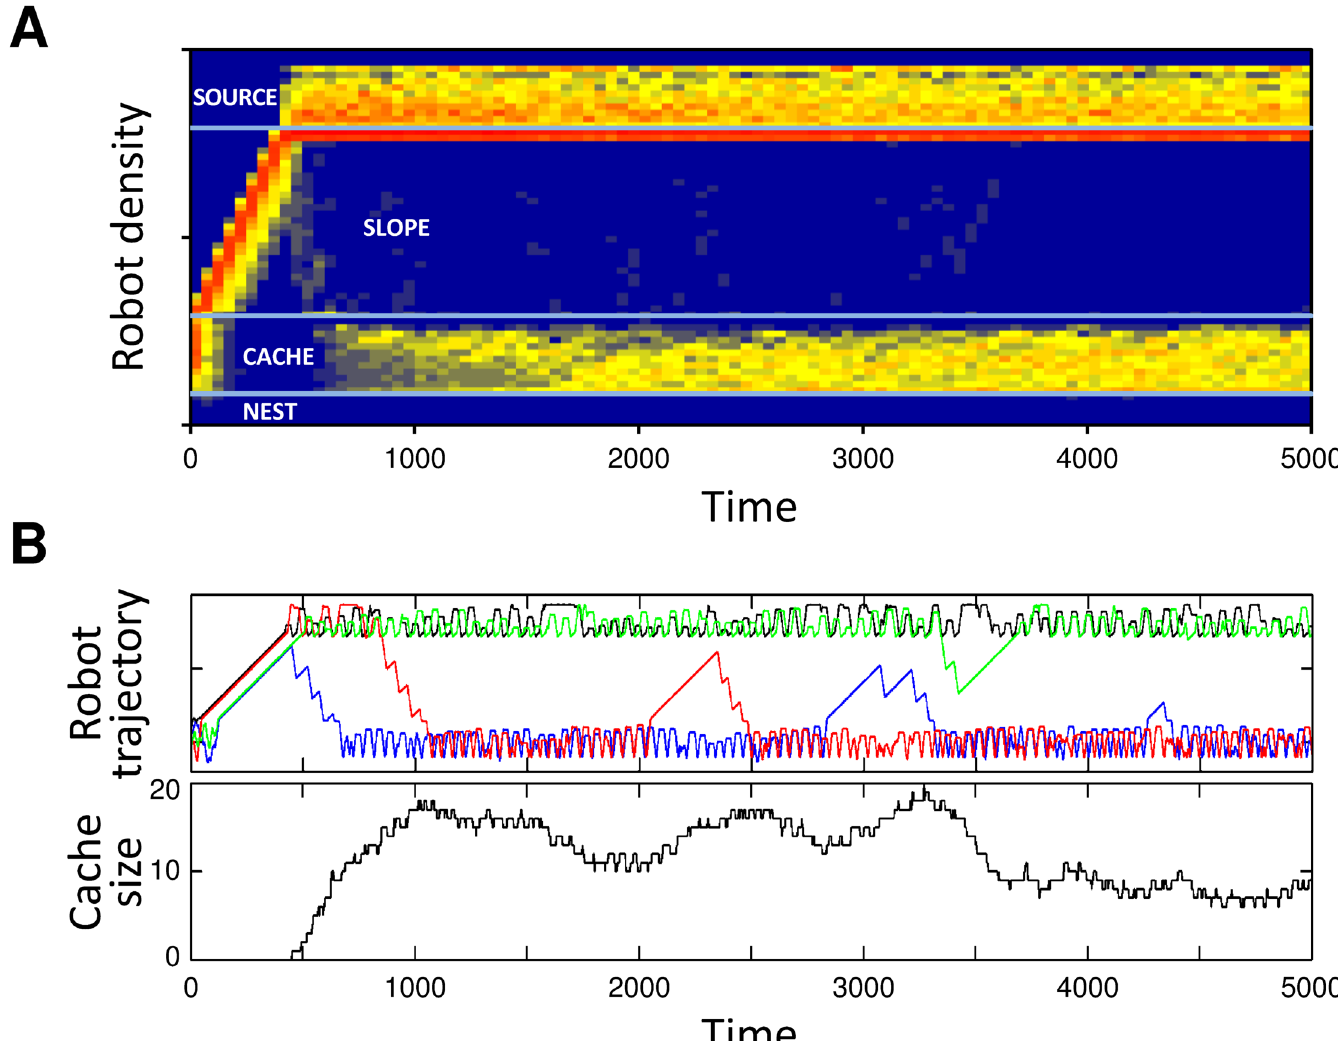
Fig 5. Self-organized task specialization and task allocation displayed by a controller evolved from first principles using Grammatical Evolution (cf. S3 Video and evolved rules shown in S2 Table). (a) Robot densities in the experimental arena of as a function of time (average of 30 runs). Despite having identical controllers, robots segregate quickly between the source and cache areas, thereby avoiding the costly traverse of the slope. (b) Robot trajectory on the arena and cache size in a typical evaluation run. All robots first move to the source to collect items, but after 500 – 1000 s into the simulation, the robot teams self-organize to have two droppers pushing items off the slope and two robots collecting items from the cache, without these tasks having been explicitly rewarded during the evolutionary runs.